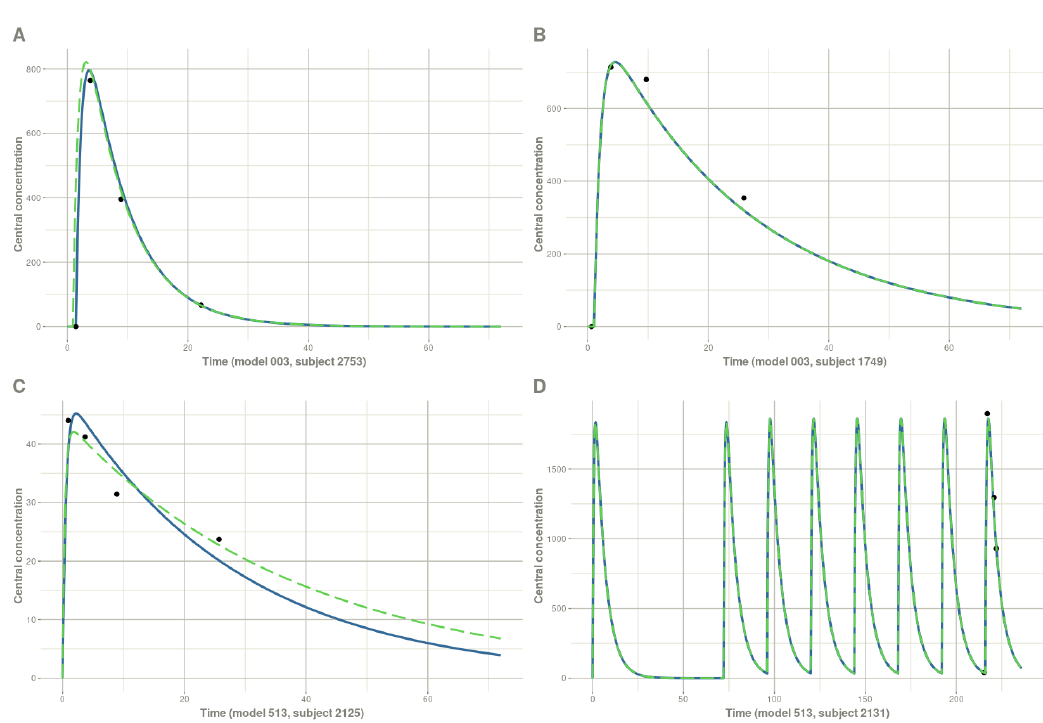
Figure A1. Simulated pharmacokinetic profiles from MAP estimates of posologyr (blue solid line) and NONMEM (green dashed line). ( A , C ): discordant profiles ( Δ𝜂̂ 𝑖 > 0.050). ( B , D ): concordant profiles ( Δ𝜂̂ 𝑖 < 0.001). Black dots: observed concentrations.